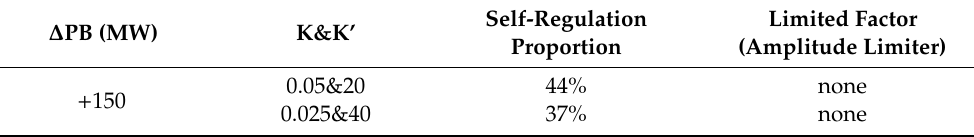
Figure 9. VF curves and PFR curves (K = 0.05, K’ = 20 and K = 0.025, K’ = 40).